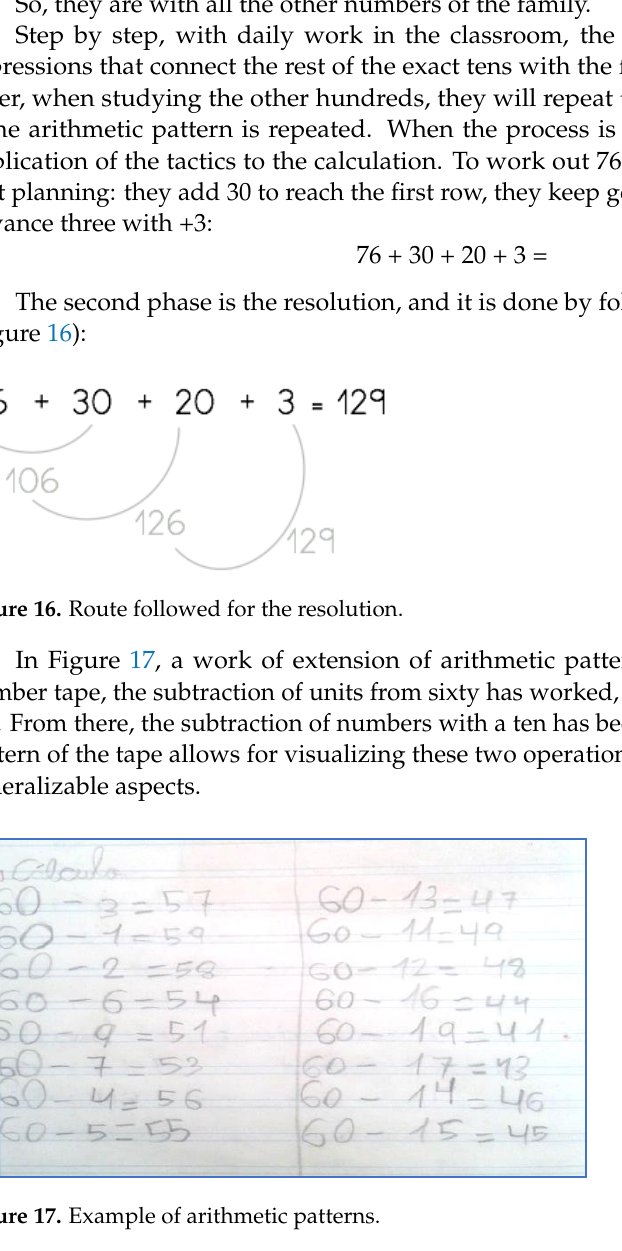
Figure 18. Example of arithmetic pattern in subtraction.